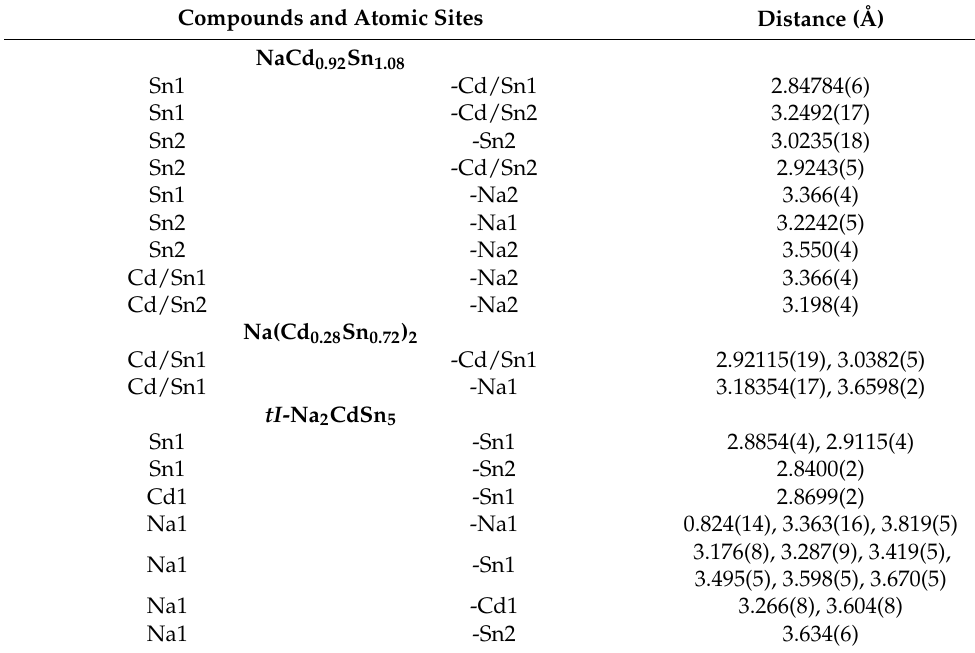
Table 3. Selected interatomic distances within 4 Å for NaCd 0.92 Sn 1.08 , Na(Cd 0.28 Sn 0.72 ) 2 , and tI - Na 2 CdSn 5